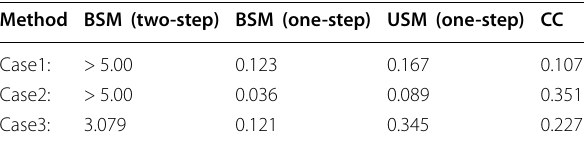
Table 4 Root of mean squared error (RMSE) in three cases of simulation, t distribution with 3 degrees of freedom